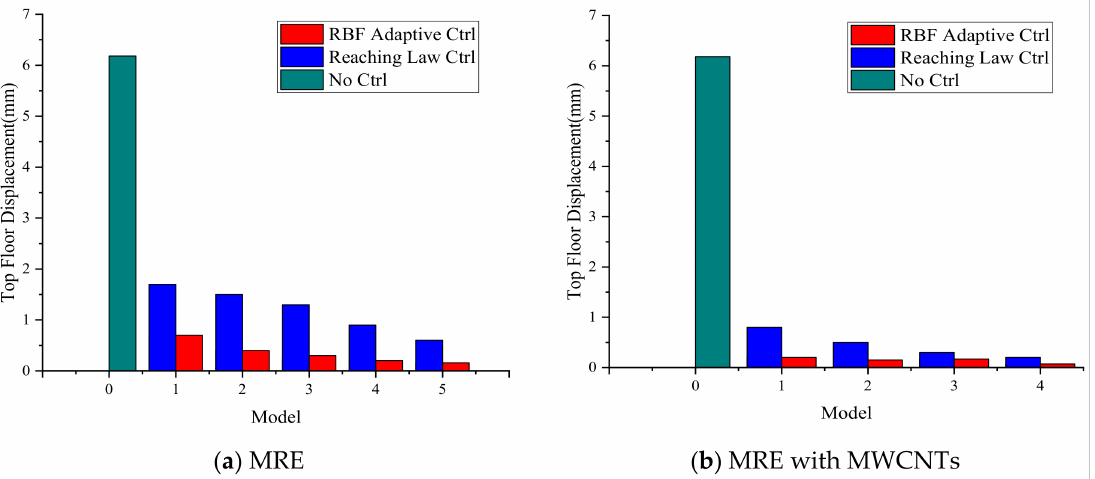
Figure 21. Top Floor Displacement for Different Control